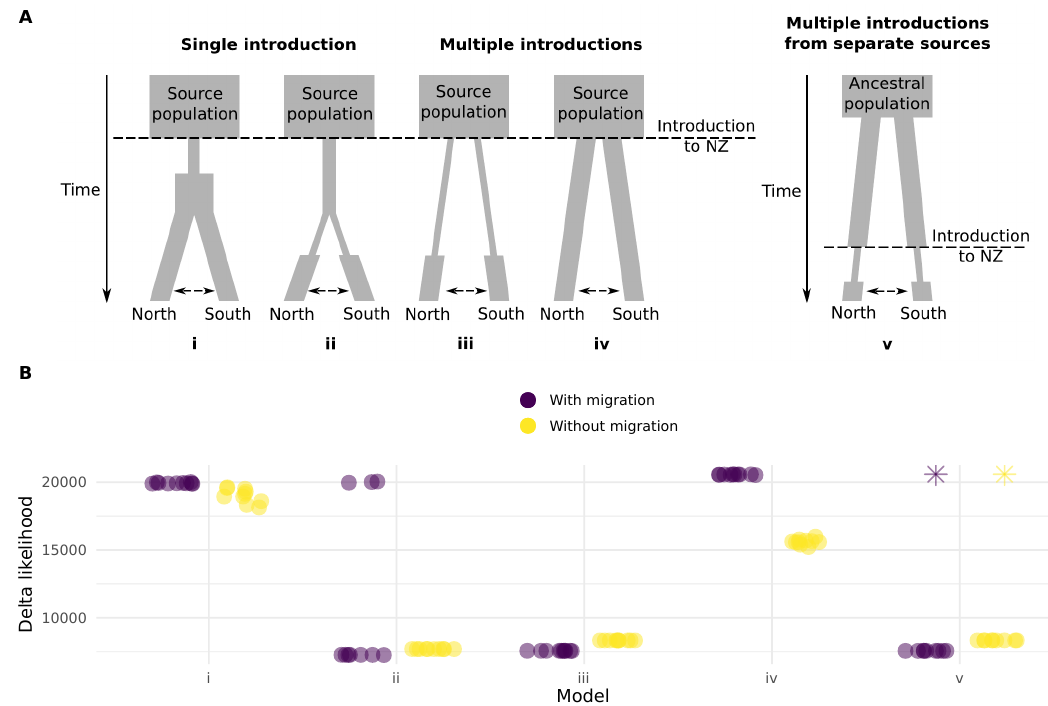
Figure 3. Models used to simulate site frequency spectra (SFS) for comparison against the observed SFS. ( A ) Models i and ii represent introduction via a single route. In model i the population contracts on introduction and then begins expanding before dispersal. In model ii, dispersal occurs while the e ff ective population size remains small. Models iii and iv represent multiple routes of entry, with or without reduction in population size compared to the current populations in New Zealand. Model v represents introduction to di ff erent sites from source populations that were isolated prior to introduction. All models were tested with and without migration between Northern and Southern populations. ( B ) Likelihood estimations from ten runs of each model. We used 1M simulations and 60 optimisation cycles per run [46]. Runs that ended with a non-finite delta likehood after 1M simulations are shown as an asterisk. The models that include a bottleneck after separation of the two populations had the lowest delta likelihoods, and model iii (with migration) had the lowest mean delta likelihood across